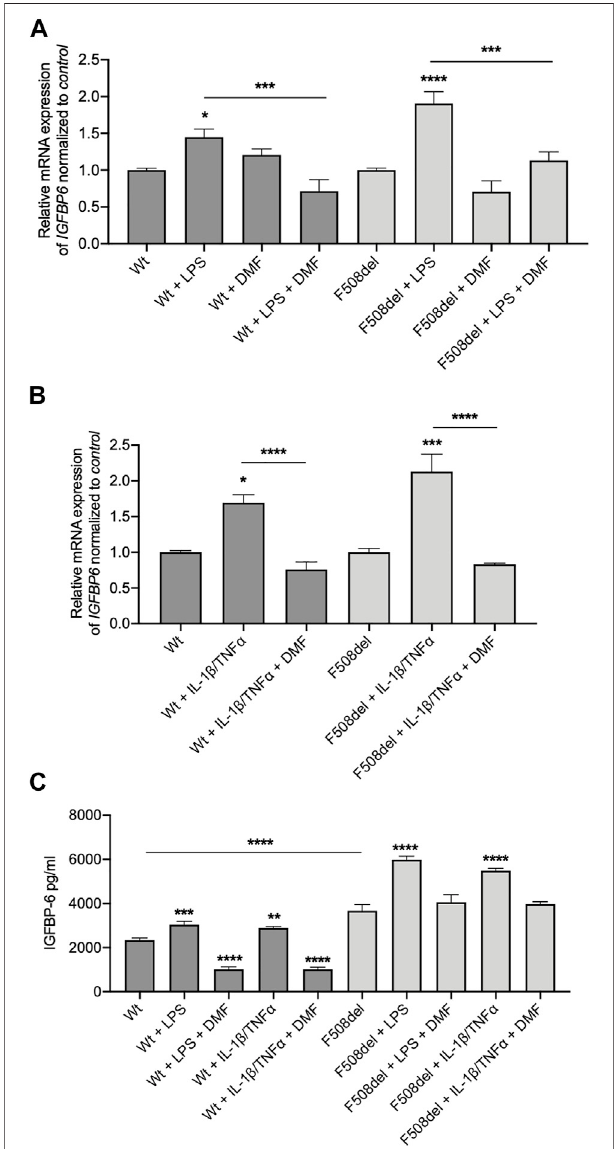
FIGURE 2 | IGFBP-6 is reduced by Dimethyl fumarate. (A) Cells were treatedwith0.1%DMSO,1 μ g/mlLPS±50 µMDMFor (B) PBS,30 ng/mlIL- 1 β +30 ng/mlTNF α ± 50 µMDMFfor4 h.TotalRNAwasextractedandqRT- PCR was performed in order to quantify IGFBP mRNA normalized to GADPH as housekeeping gene and then to control untreated cells. Data representthemean±SEM( n =4). (C)